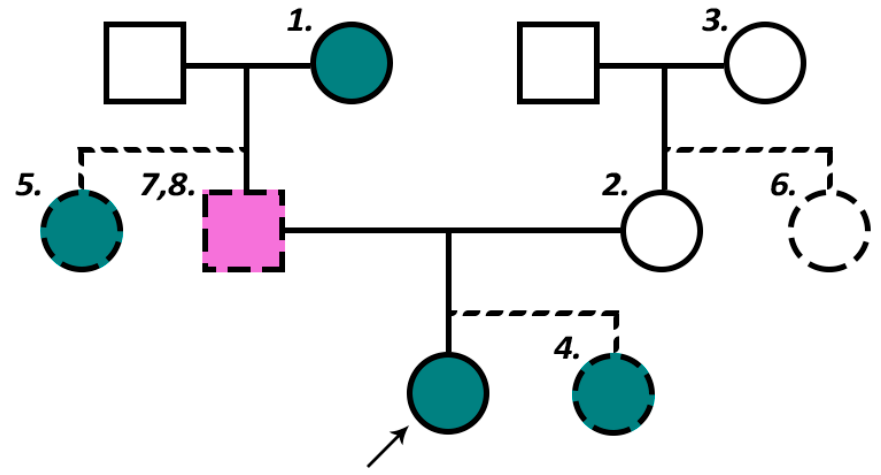
Figure 3. Pedigree structure enriched for X-linked ovarian cancer. Teal represents an ovarian cancer case. Purple represents any cancer case. Numbers correspond to numerated criteria from text. Note that, in this example, dashed lines represent elective criteria.